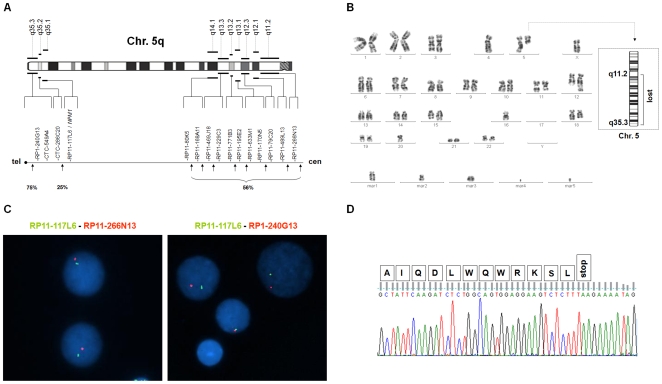
FISH, cytogenetics and mutational analysis.
A) Results of FISH in 38 patients with MDS/AML and NPM1 monoallelic deletion (NPM1+/−): schema of 5q breakpoints. Upper: ideogram of the long arm of chromosome 5 in G banding. Lower: genomic clones at proximal (q11.2– q14.1 sub-bands) and distal (q35.1–q35.3 sub-bands) breakpoints with percentages of cases. B) G-banded karyotype of a representative case (n.103, Supporting Table S1) showed a complex karyotype including monosomies, unbalanced translocations, five markers, and a very small deleted chromosome 5 corresponding to the largest 5q deletion including NPM1 with breakpoints at q11.2 and q35.3 (Right ideogram). C) FISH of case n.103: concomitant deletion of RP11-117L6/NPM1 (green) and RP11-266N13 (red) indicate centromeric breakpoint (left) and RP1-240G13/subtelomeric sequences (red) indicate telomeric breakpoint (right). Only one copy of each clone is present. D) Gene sequencing of case n.103 shows no NPM1 exon 12 mutation in the non-deleted chromosome 5. The last 12 amino acids encoded by exon 12 of wild type NPM1 (NM_002520) are annotated on top of the sequence.